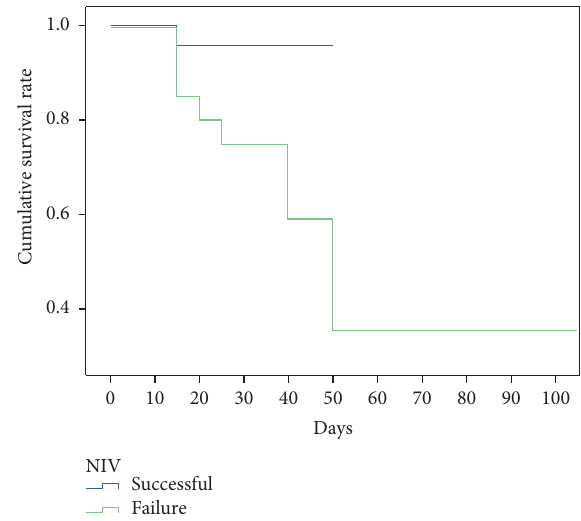
Figure 2: Survival rate of the two